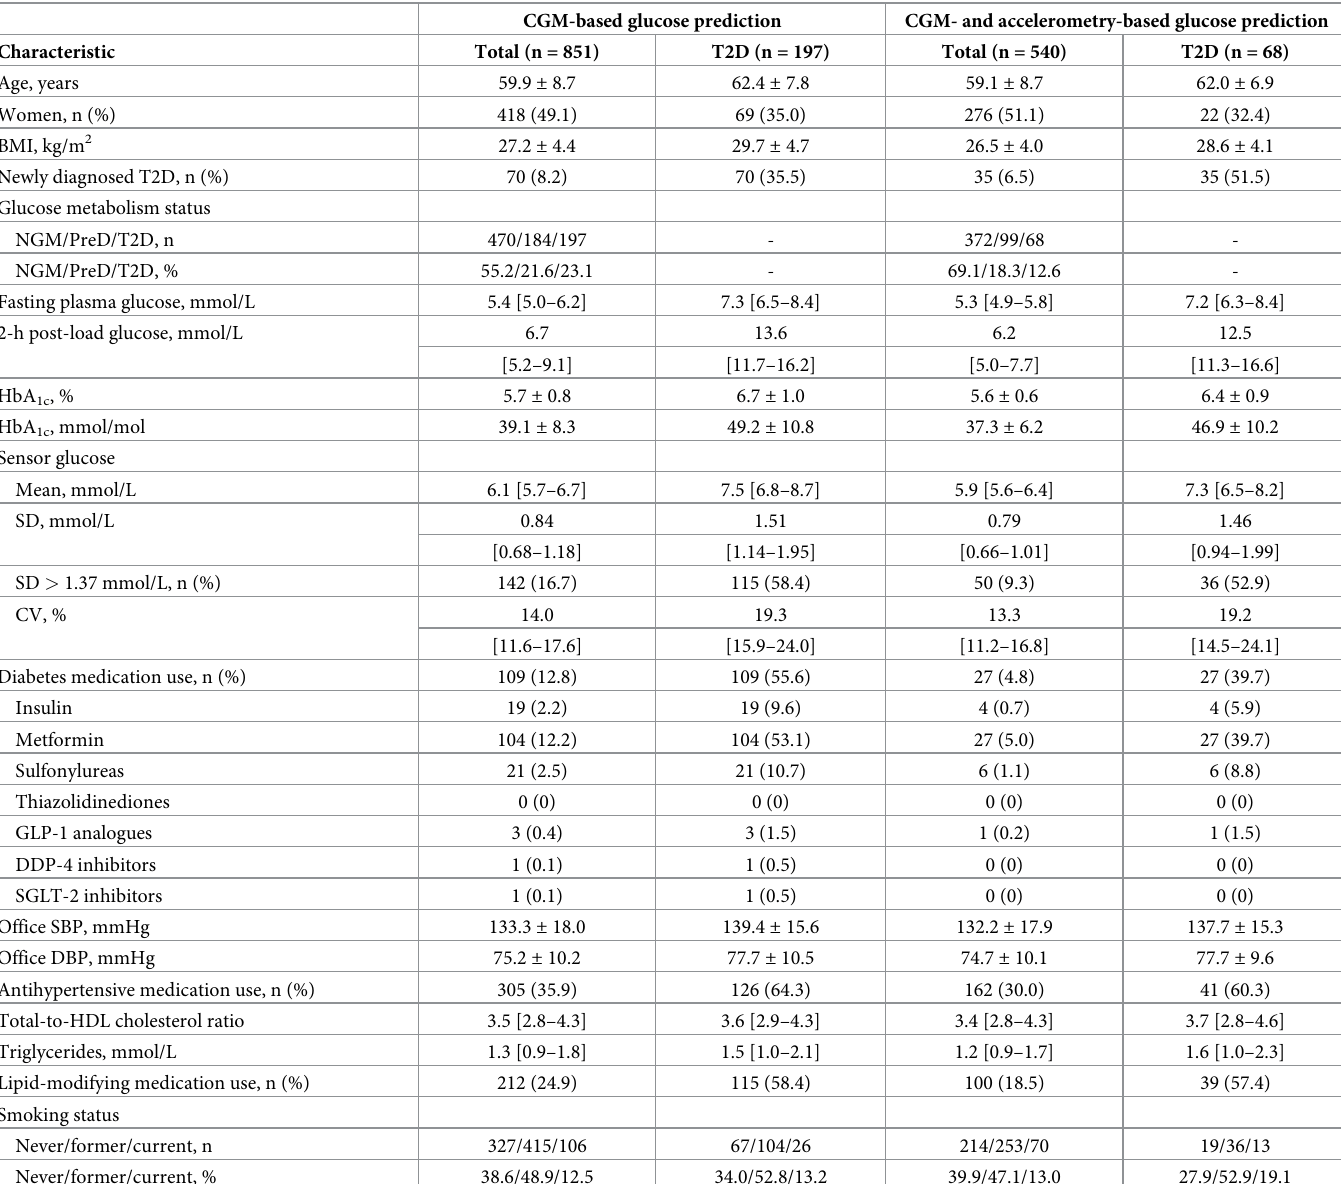
Table 2. Participant characteristics of the CGM-based and CGM- and accelerometry-based glucose prediction study populations. CGM-based glucose prediction CGM- and accelerometry-based glucose